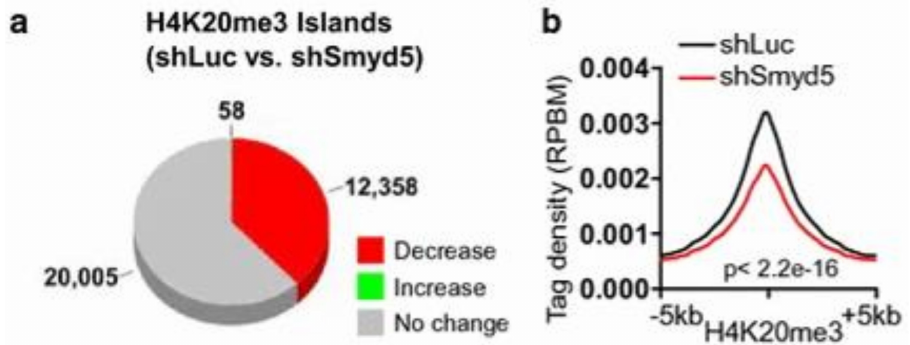
Figure 11. ( a ) A widespread decrease in H4K20me3 occurs with SMYD5 knock down. ( b )